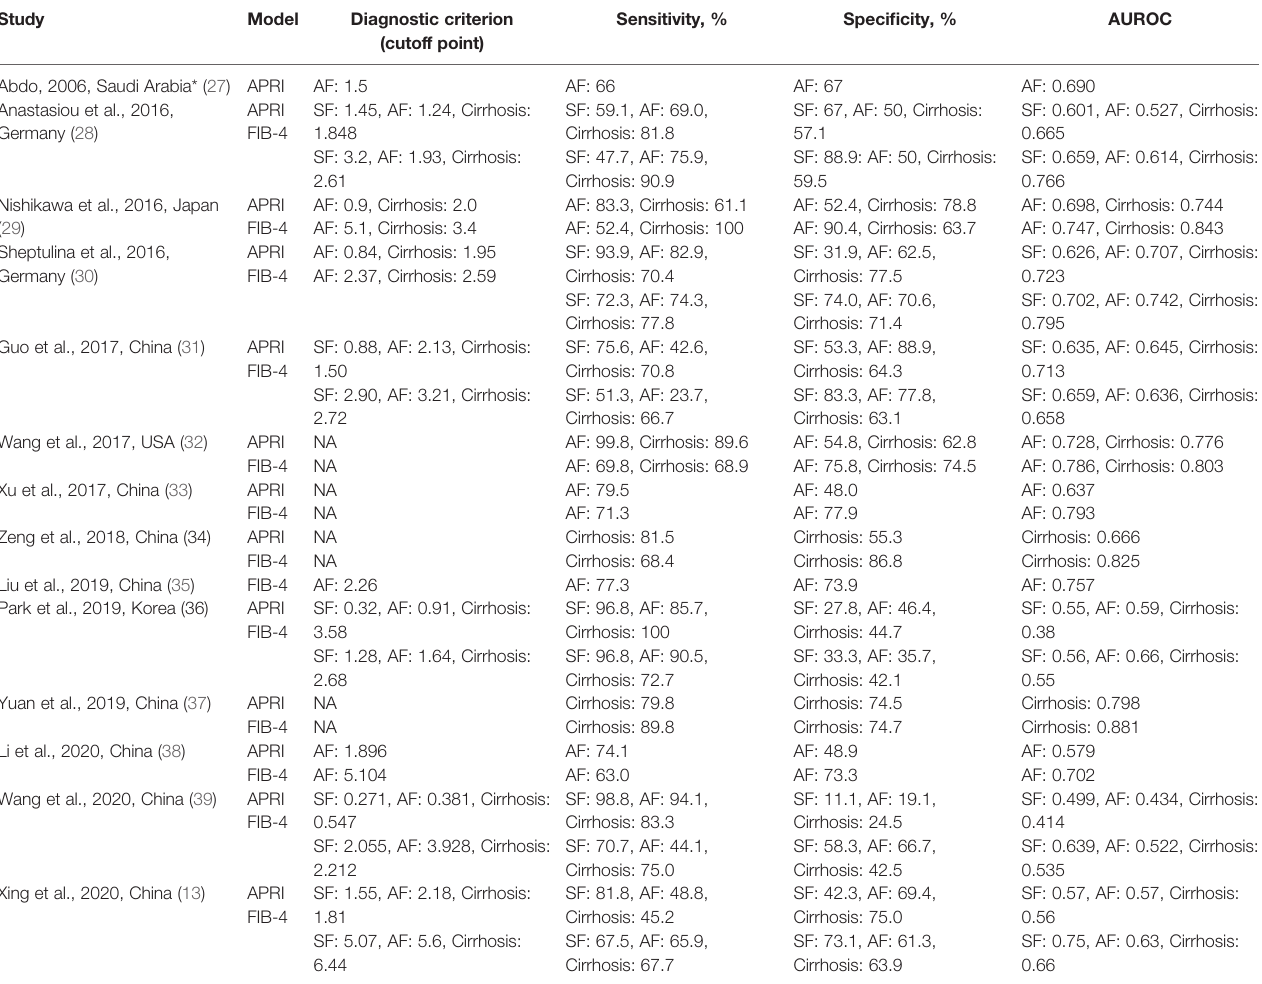
TABLE 2 | APRI and FIB-4 diagnostic performance for detecting liver fi brosis in